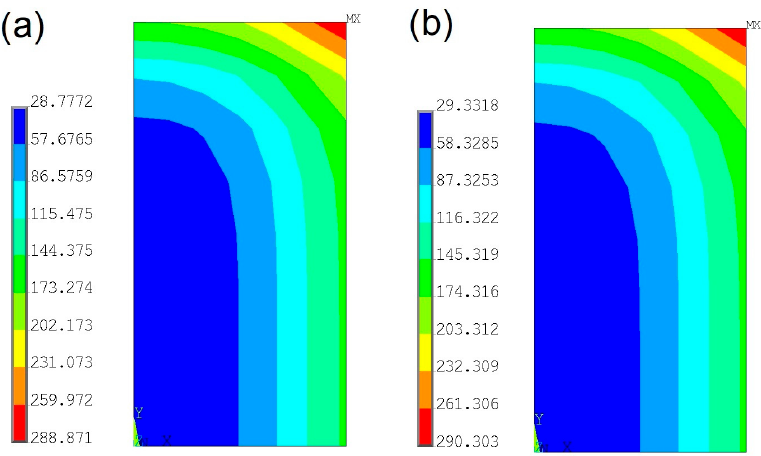
Figure 11. Temperature distribution after 70.8 s of the heating process: calculated based on the exact heat fluxes ( a ), and by the AMI method with σ = 0.05 ( b ).